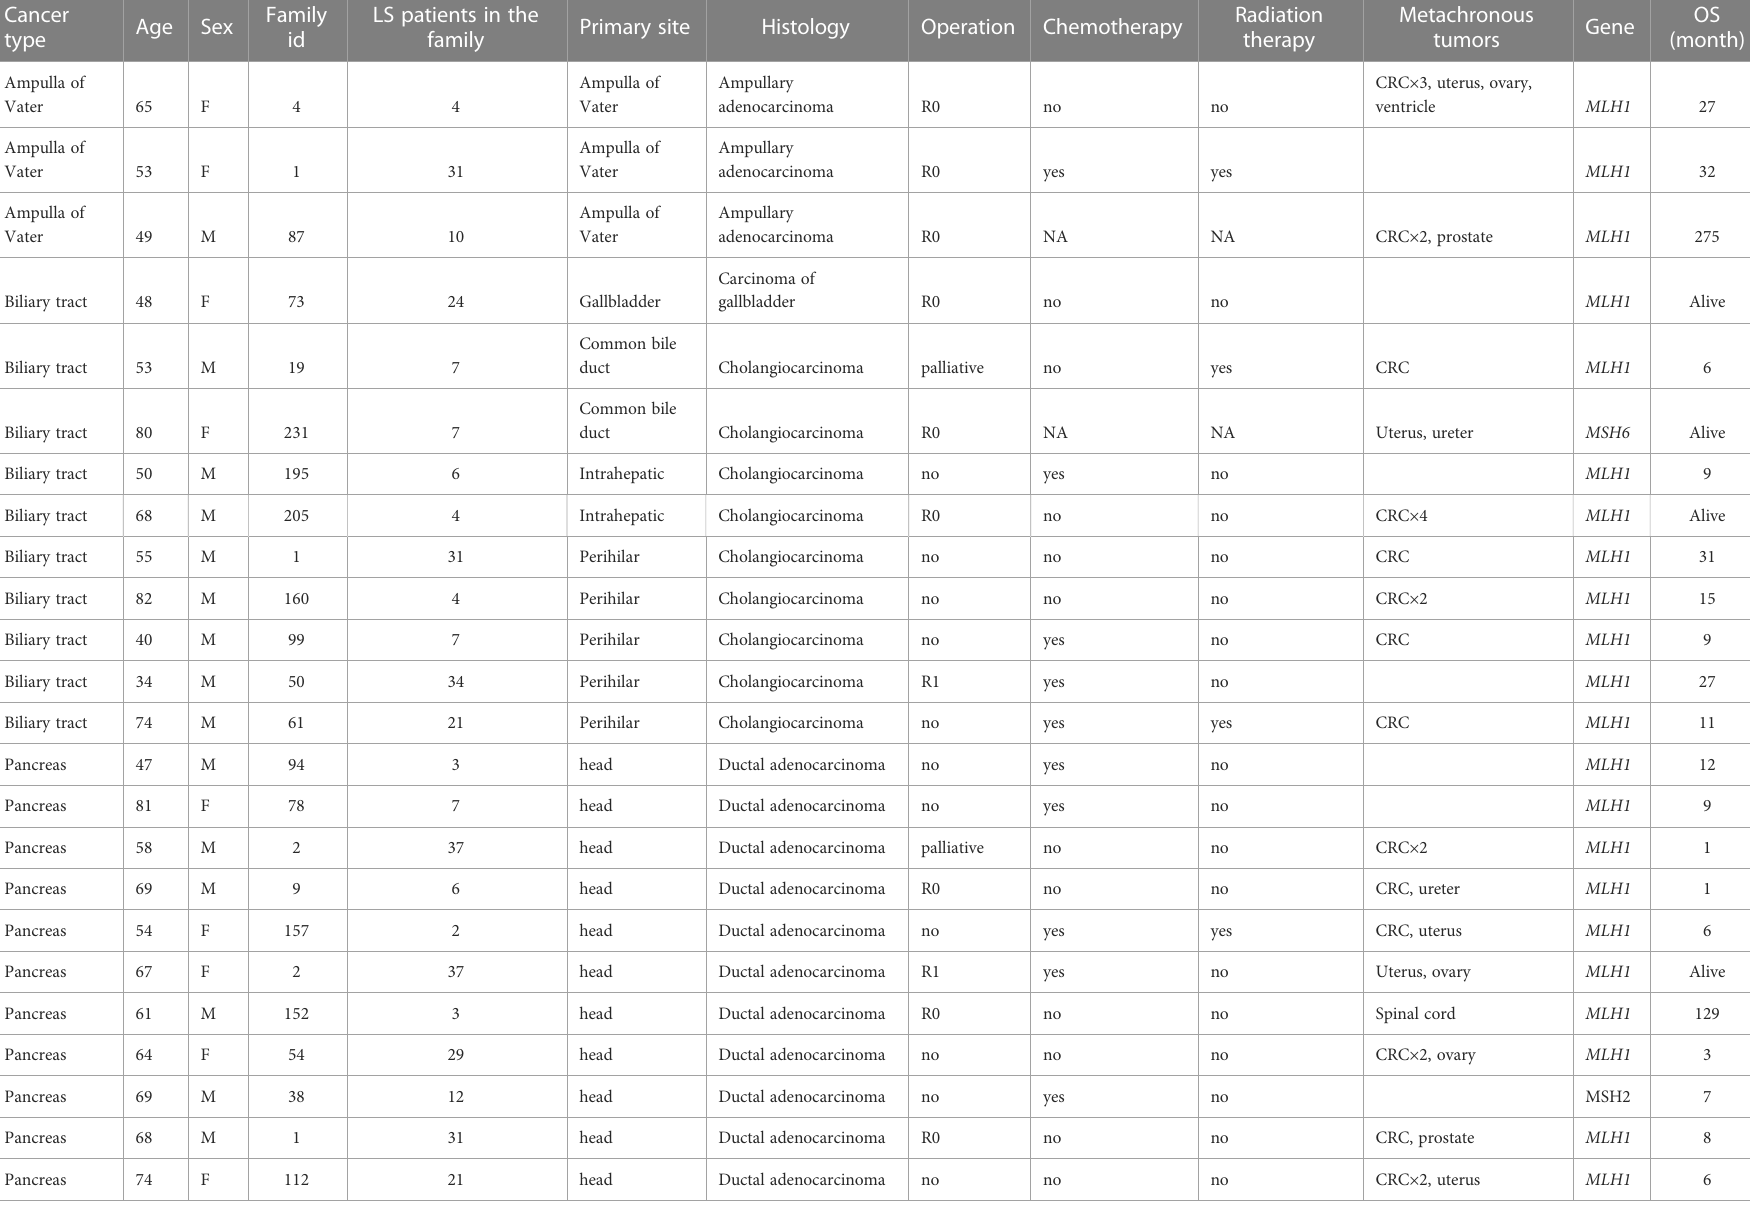
TABLE 1 Clinicopathological characteristics of PC, BTC, and ampullary cancer in LS patients. Cancer